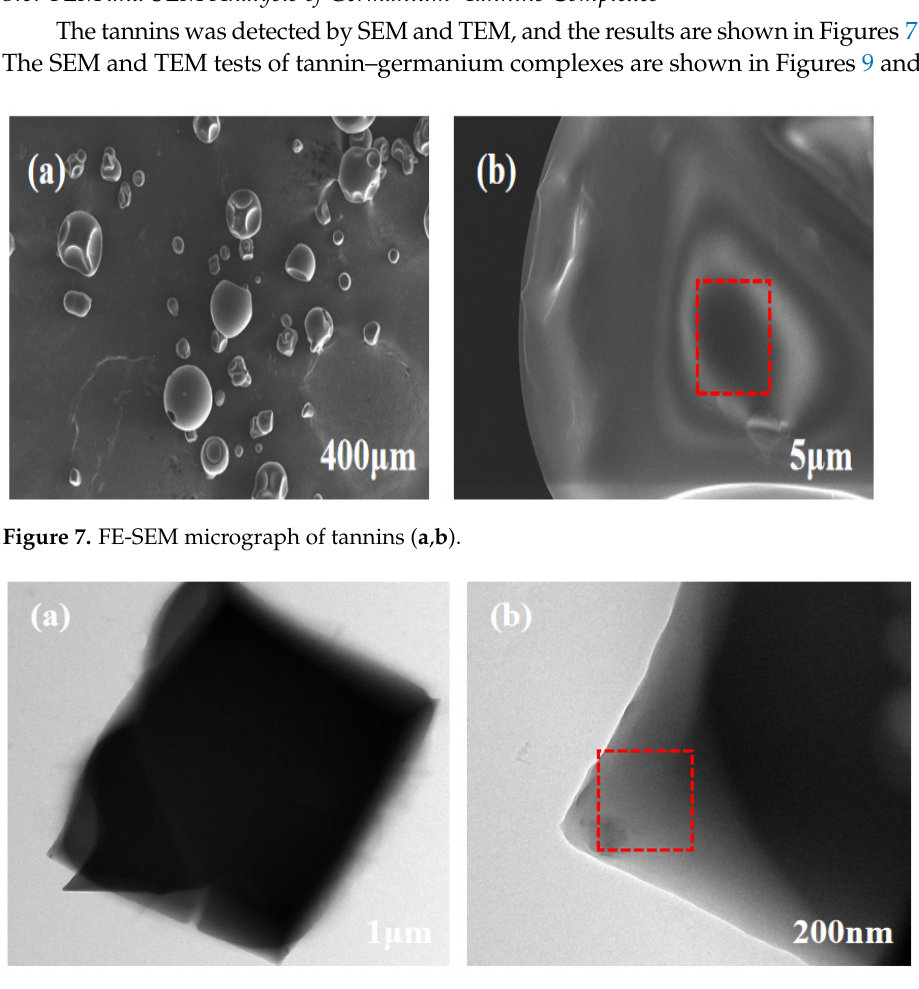
Figure 9. FE − SEM micrograph of germanium–tannins ( a , b ).